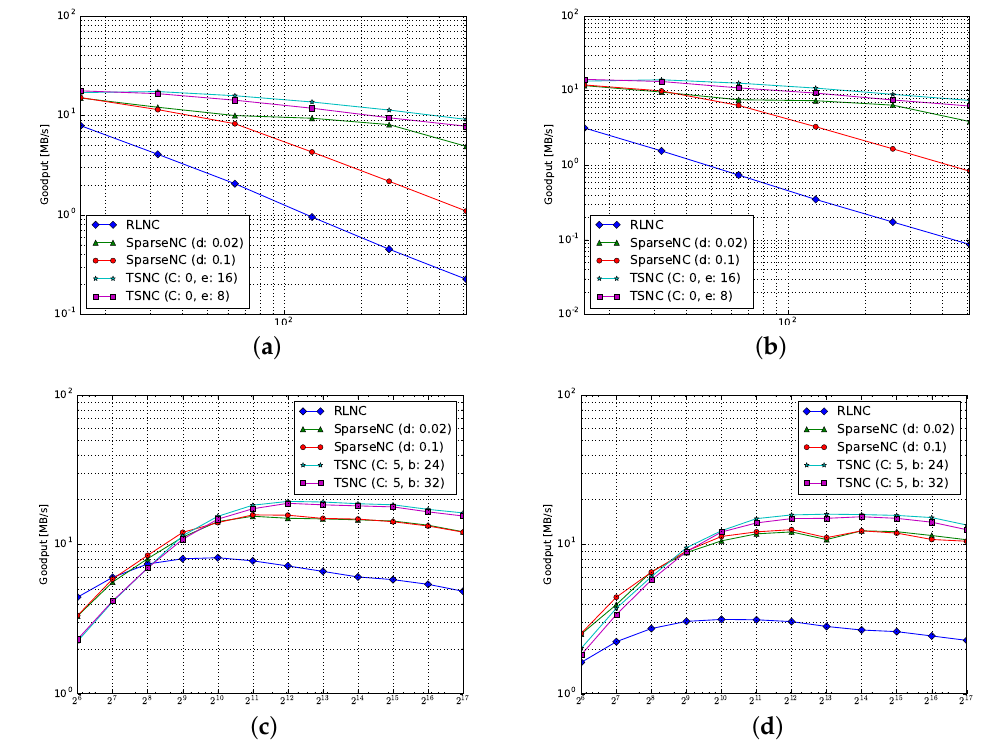
Figure 4. Encoder goodput measurements for the Raspi 1. ( a ) Goodput vs. generation size for q = 2; ( b ) goodput vs. generation size for q = 2 8 ; ( c ) goodput vs. packet size for q = 2, g = 16; ( d ) goodput vs. packet size for q = 2 8 , g =